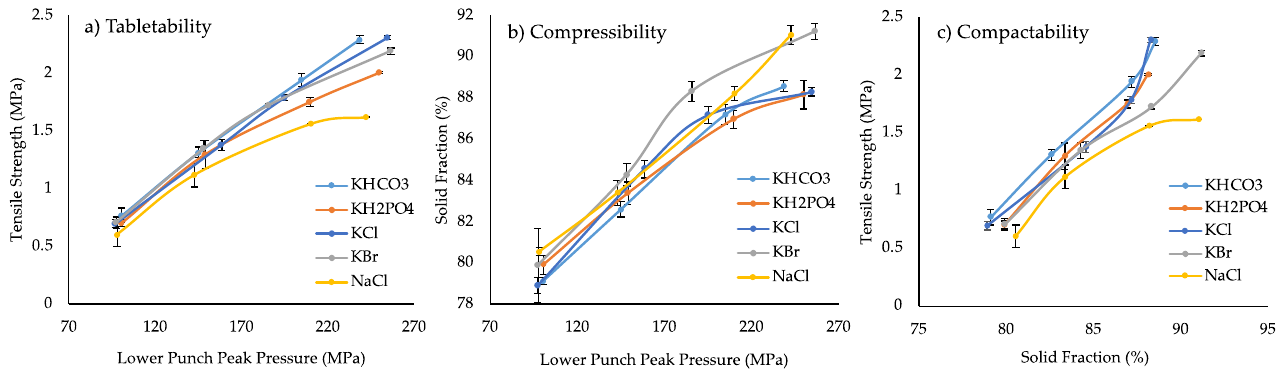
Figure 7. Tablets of ITZ-KOL-ASDs with inorganic salts (KHCO3, KCl, KBr, KH2PO4 and NaCl); ( a ) tabletability, ( b ) compressibility and ( c ) compactibility (n = 6). Four salts, NaCl, KCl, KH 2 PO 4 and KBr, achieved the target disintegration time of less than 15 min (Figure 8a). NaCl disintegrated the fastest (2.29 min), followed by KCl and KH 2 PO 4 (4 min) and finally KBr (6.4 min). NaCl demonstrated the quickest disintegration